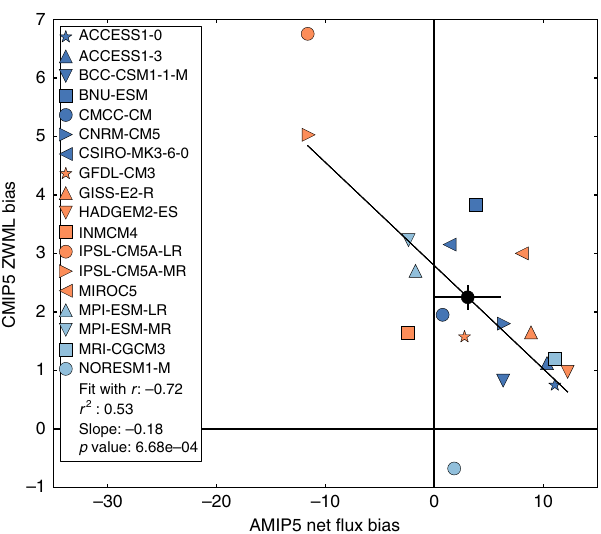
Fig. 3 Linear regression of estimated biases in the latitude of the CMIP5 maximum zonal mean 10 m westerly wind on the estimated 40 – 60°S AMIP5 net fl ux biases. Zonal wind maximum latitude (ZWML) biases are relative to ERA Interim with positive values indicating northward biases.